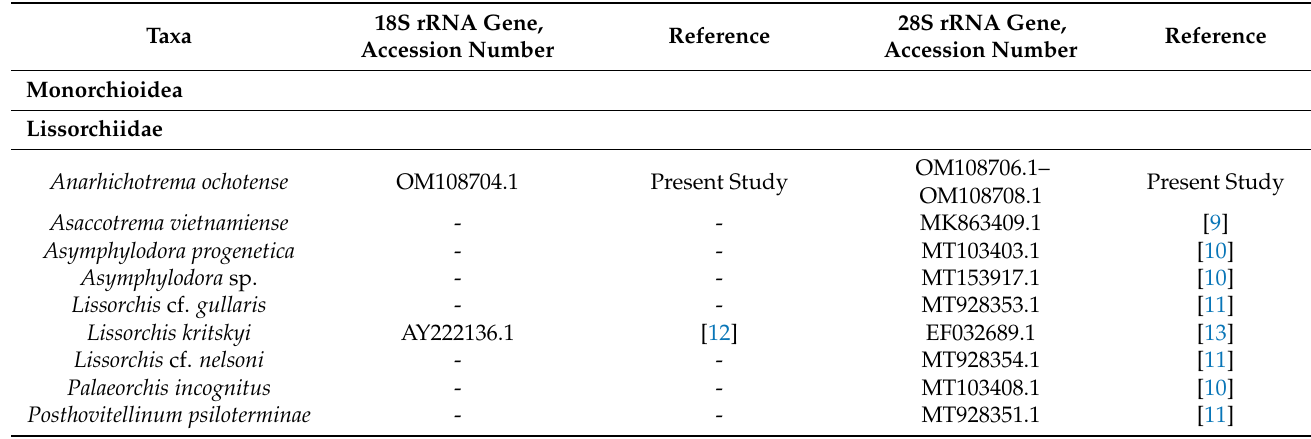
Table 1. Trematode species involved in phylogenetic